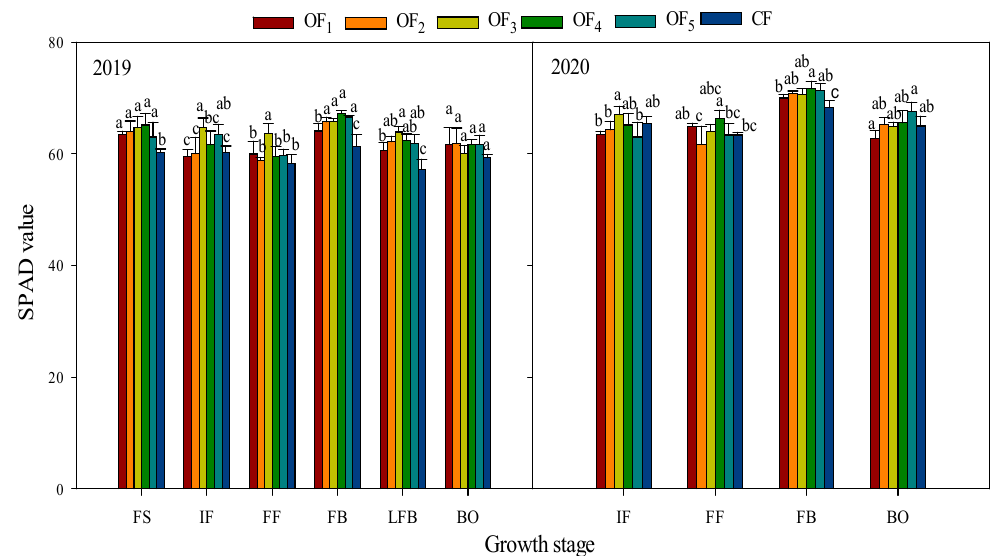
Figure 2. Effect of organic liquid fertilizer combined with different ratios of chemical fertilizer on the SPAD values of cotton. FS, full-squaring stage; IF, initial flowering stage; FF, full-flowering stage; FB, full-boll stage; LFB, late full-boll stage; BO, boll-opening stage. Different letters above the columns indicate statistical significance at the p = 0.05 level within the same growth stage in each year.